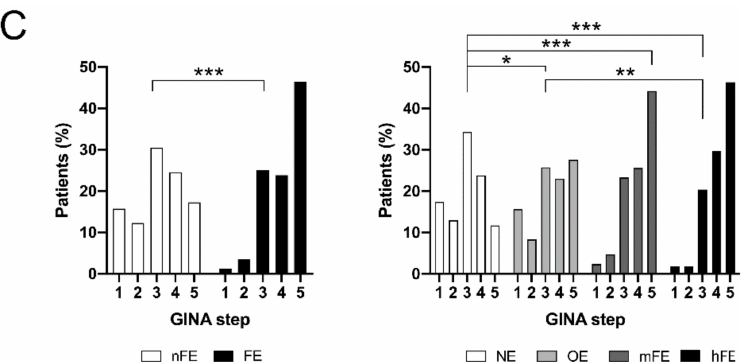
Figure 2. Asthma control in the asthmatic population after stratification according to the number of exacerbations. Results of ( A ) limitations to daily activity and ( B ) asthma control test (ACT) improve as scores increase. ( C ) The resulting treatment step according to Global Initiative for Asthma (GINA) improves as score decreases. * p < 0.05; ** p < 0.01; *** p < 0.001.